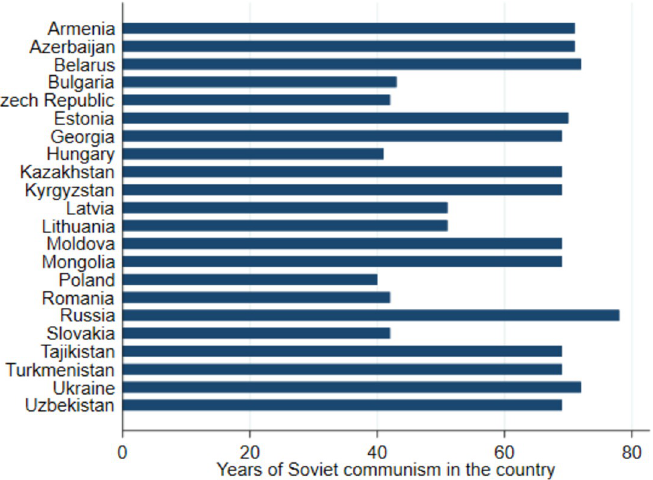
Fig 2. Number of years countries were ruled by Soviet communist regimes. Notes : The above figure shows the number of years each country was ruled by a Soviet communist regime and not the average number of years respondents in a country lived under the Soviet rule. For the latter, see S2 Table.